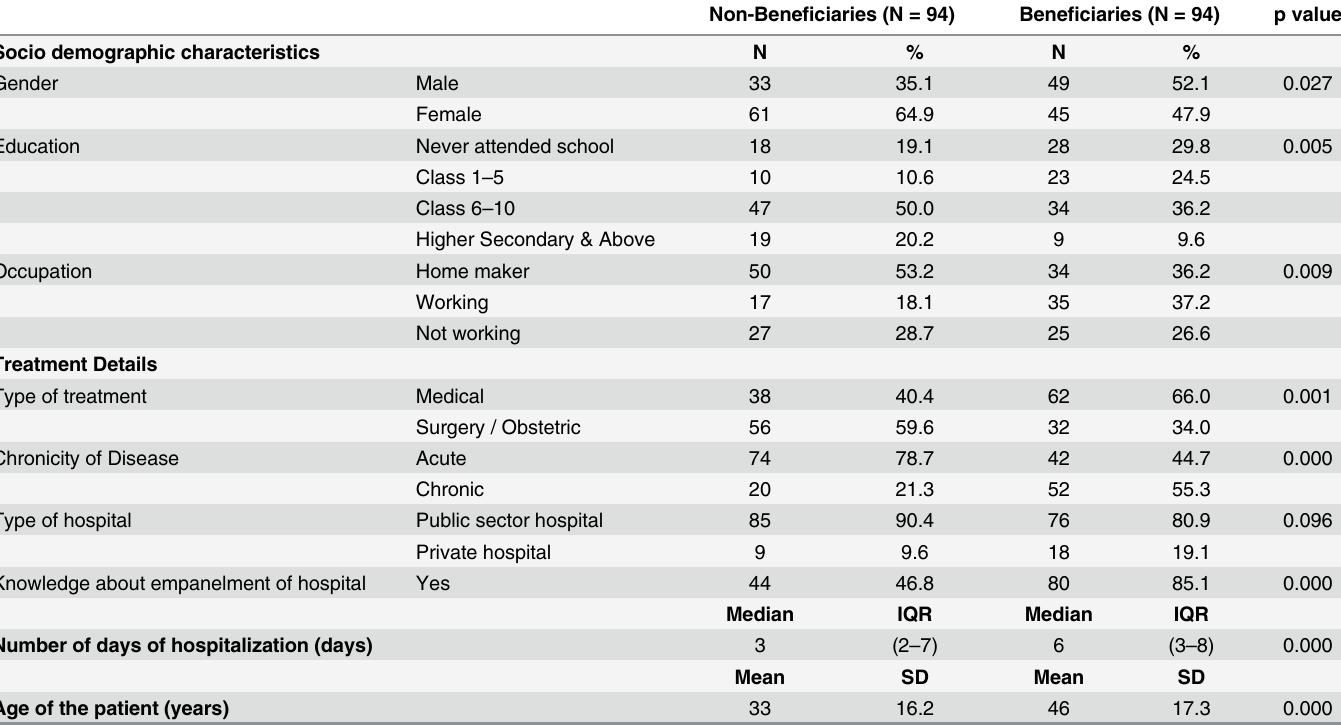
Table 2. Socio demographic and treatment characteristics of patients (covariates) of beneficiaries and non-beneficiaries, Solan, Himachal Pra- desh, India,